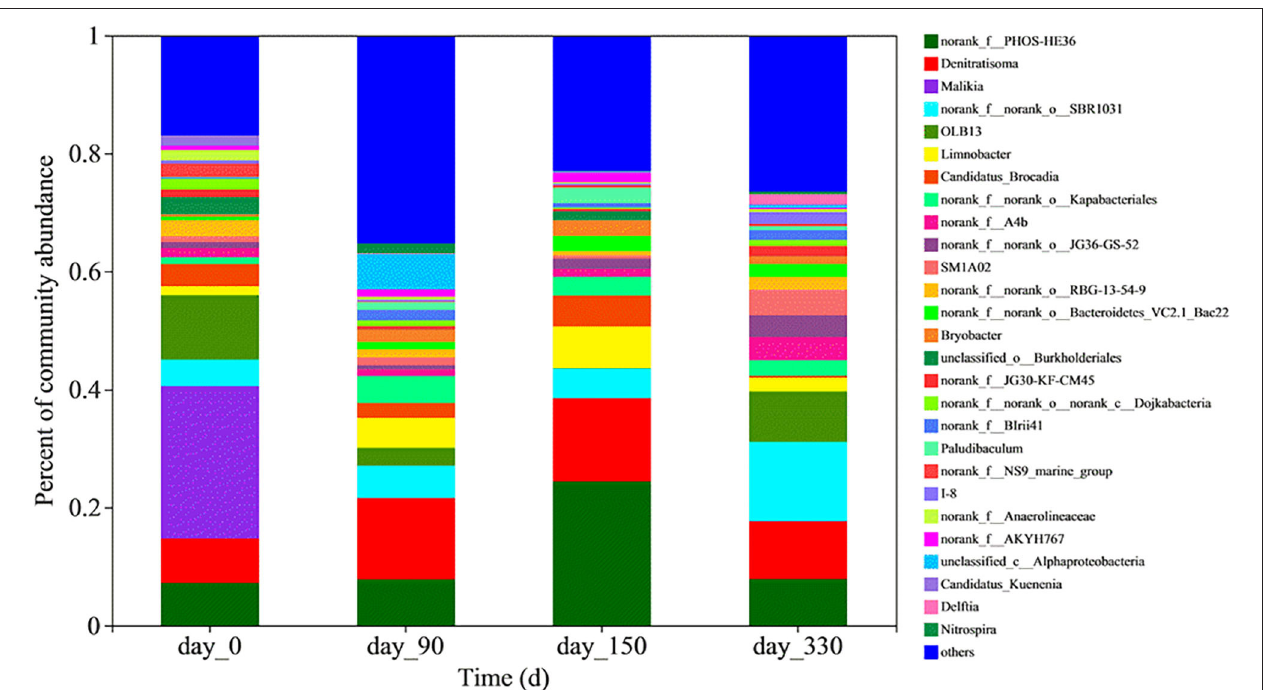
FIGURE 2 | Relative abundances of bacteria at genus level on Days 0, 90, 150, and 330 in the Feammox bioreactor.